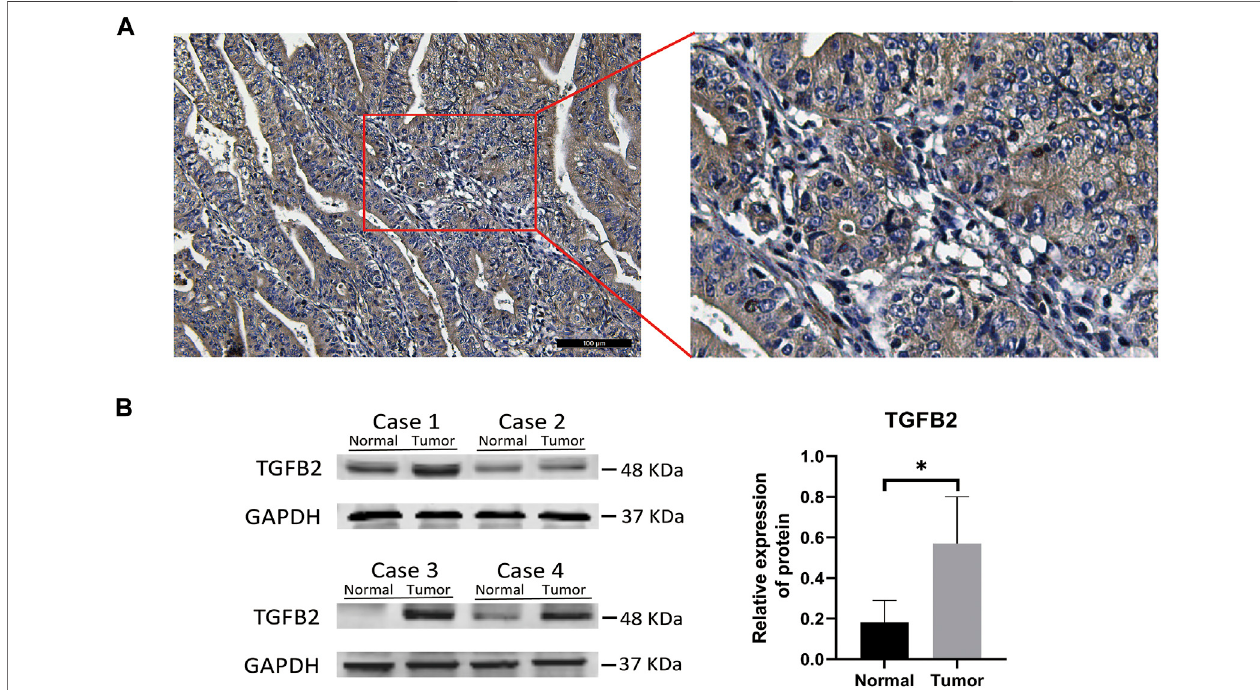
FIGURE 2 | TGF β 2 protein level detection in gastric cancer. IHC (A) and Western blot validation (B) of TGF β 2 protein in gastric cancer tissues. * p < 0.05.